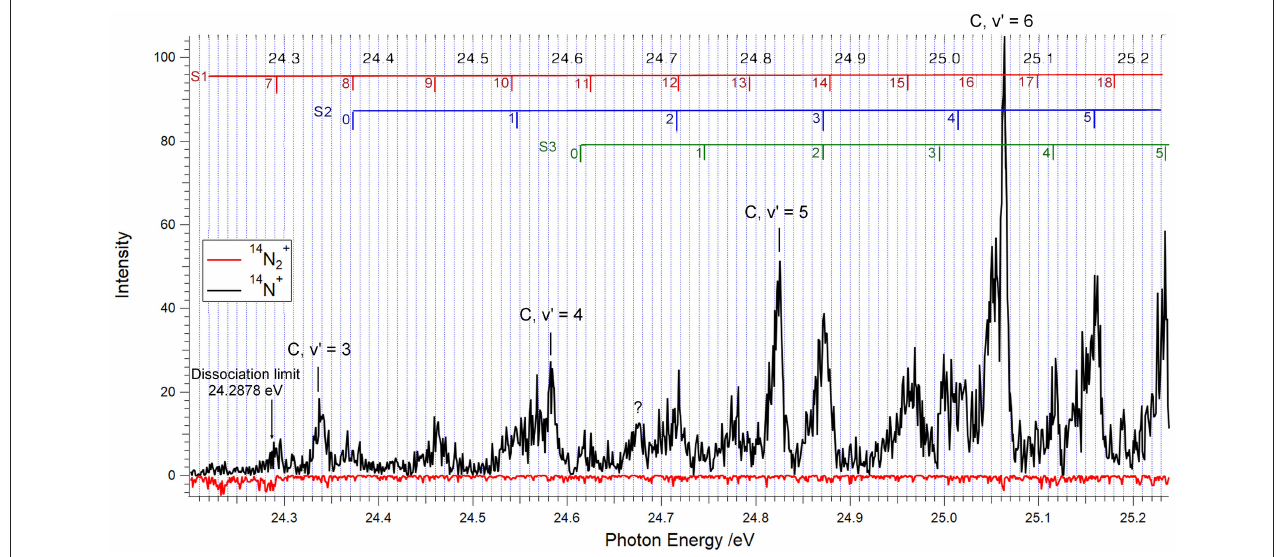
3–6 of the C 2 6 + u state of 14 N 2 + . The photon energy was =